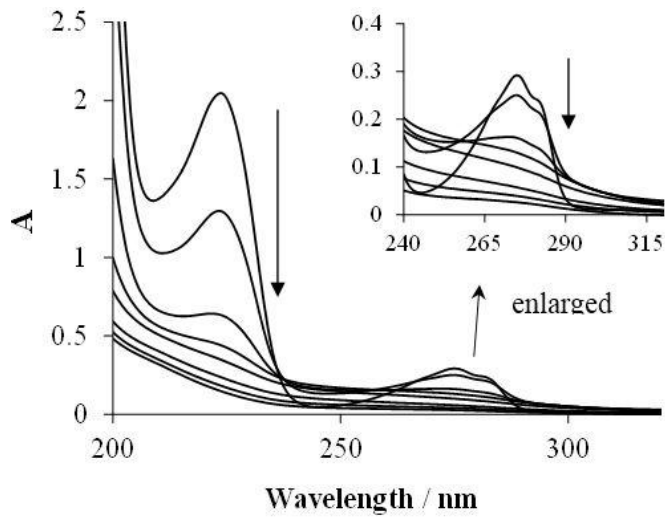
Figure 3. The change of the absorption spectrum (after removal of the suspended TiO 2 ) during the photocatalysis in the aerated system containing 2 × 10 −4 mol·dm −3 Triton X-100 and 1 g·dm −3 catalyst (ℓ = 1 cm).